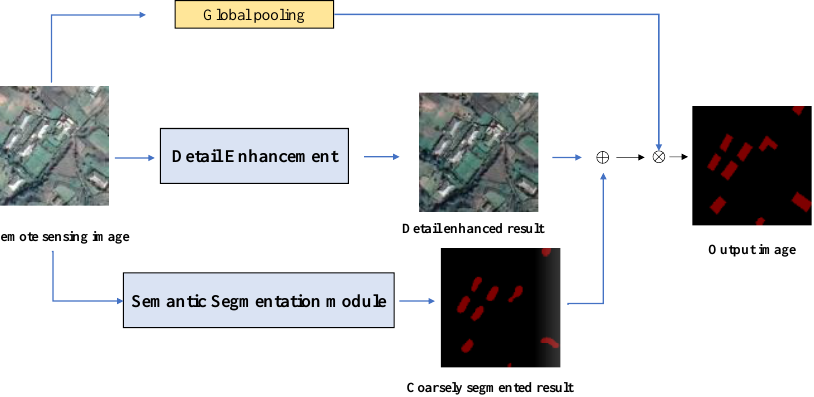
Figure 1. Overview of the building segmentation network. WASP module and Detail Enhancement module are our most important contributions in this